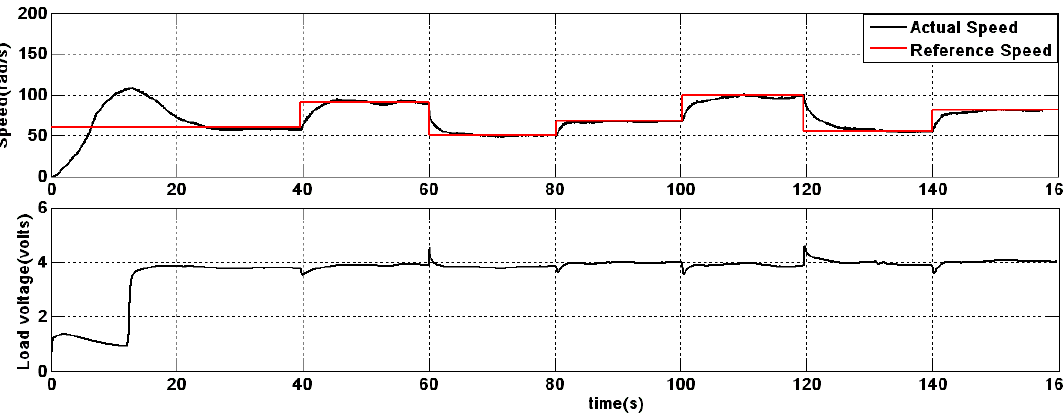
Figure 9. Speed tracking and load voltage under the adaptive SMC system with unmodeled quantity (friction).